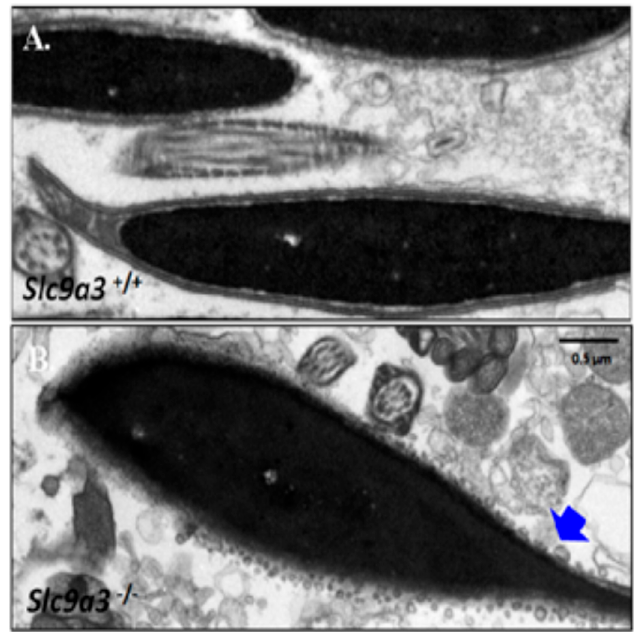
Figure 7. Ultrastructural defects of the sperm acrosome from Slc9a3 –/– mice. Sperm isolated epididymis of Slc9a3 +/+ ( A ) and Slc9a3 − / − ( B ) mice. Electron micrograph showing the ultrastructure of sperm of 35-day-old WT (upper panel) and Slc9a3 − / − male mice (lower panel). Arrow indicates the acrosome defects in sperm from Slc9a3 − / − male mice. Scale bar = 0.5 μ m.